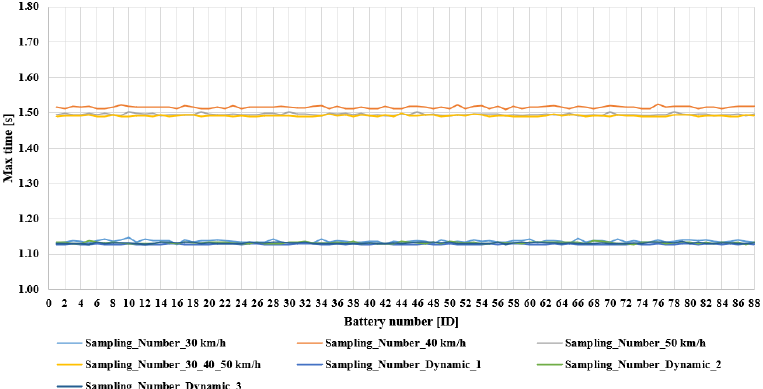
Figure 4. Average readout time per cell.